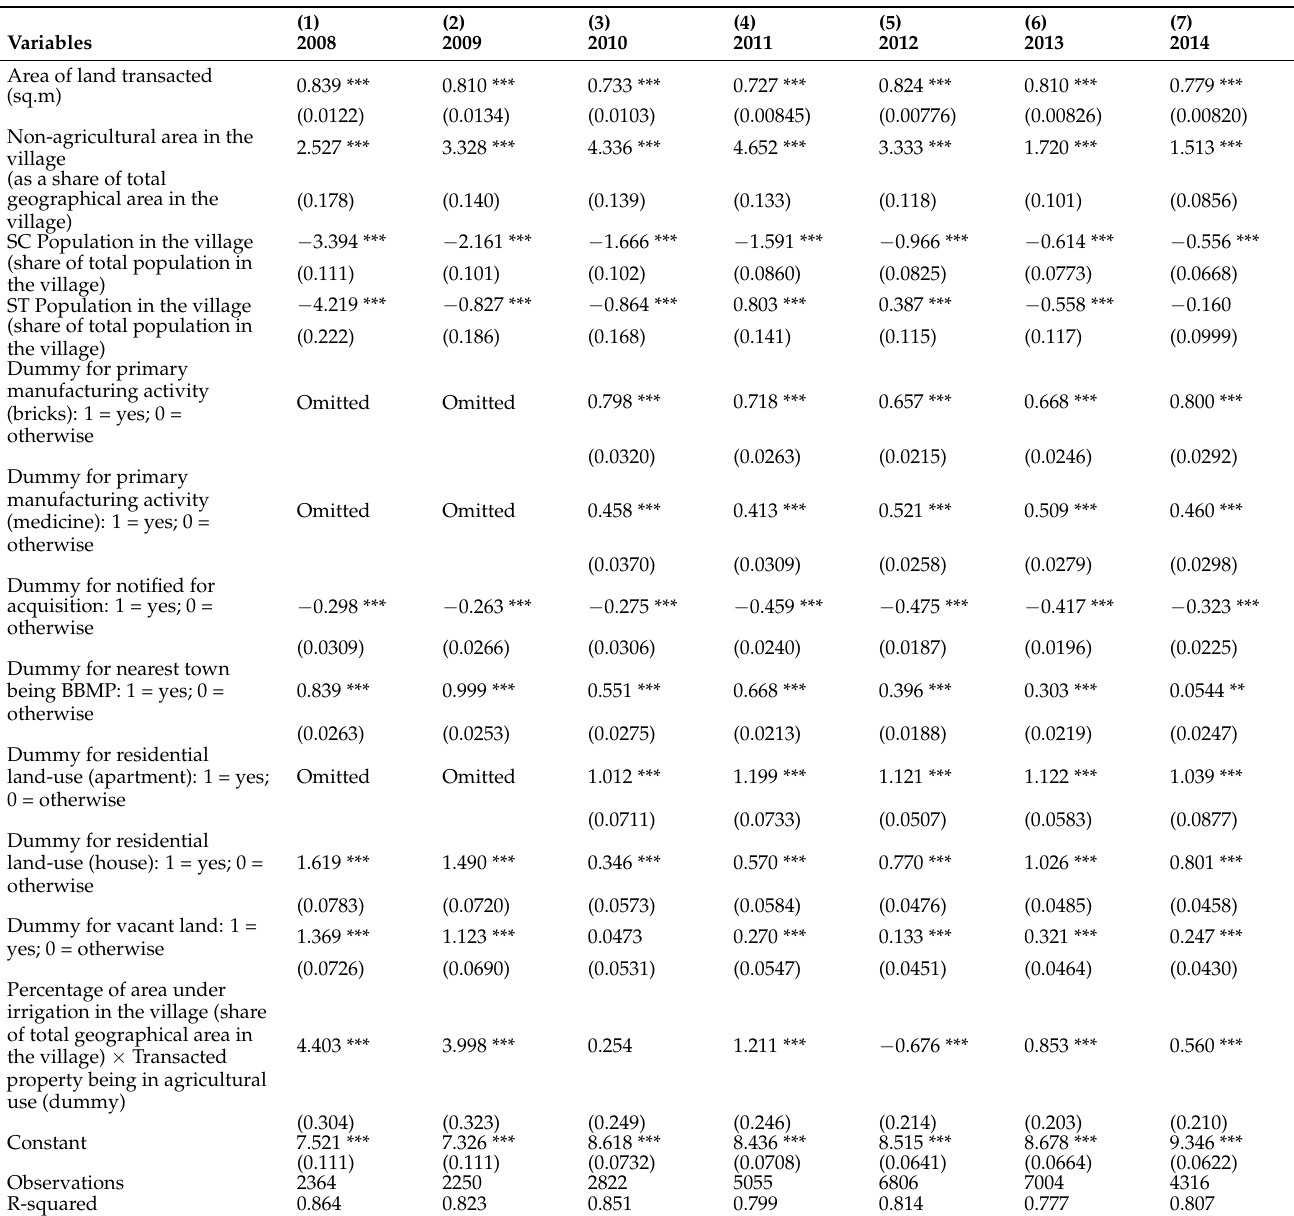
Table 3. Year-wise estimation of land value (log-log functional form) (dependent variable is